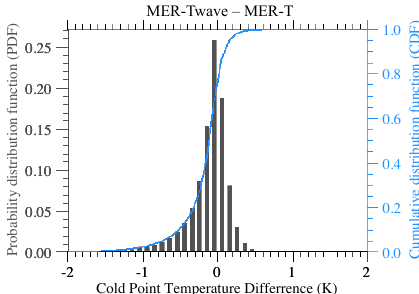
Figure 2. (a) MERRA (blue) and GPS (red) mean temperature in TTL and (b) their differences (GPS–MERRA) extended to 31hPa. All values are averaged over the deep tropics (18 ◦ S–18 ◦ N) in 2007–2013, with larger dots marking the MERRA model levels and small dots marking the MERRA in-between levels, where both GPS and MERRA temperatures are linearly interpolated to the same pressure levels.